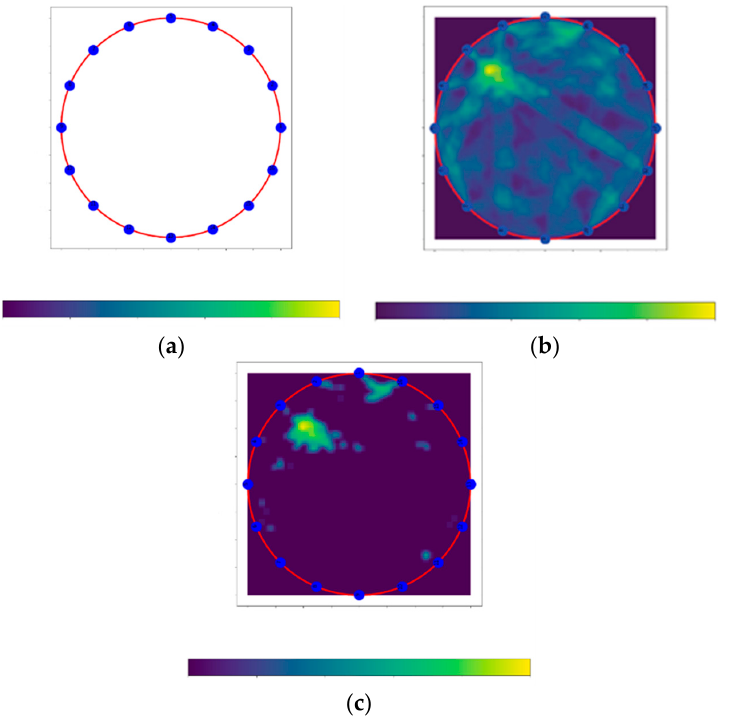
Figure 21. Extracting an object during image reconstruction: ( a ) selecting a model, ( b ) image reconstruction (visible Fresnel zones between pairs of transmitters), ( c ) successive stages of filtration to highlight the object.